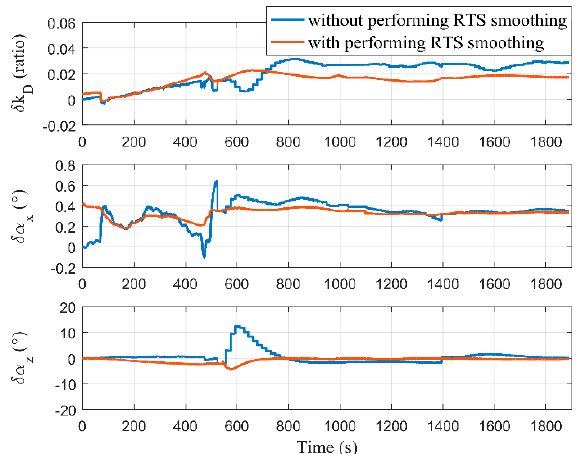
Figure 12. Estimation results of the odometer scale factor and mounting angles with and without performing RTS smoothing.